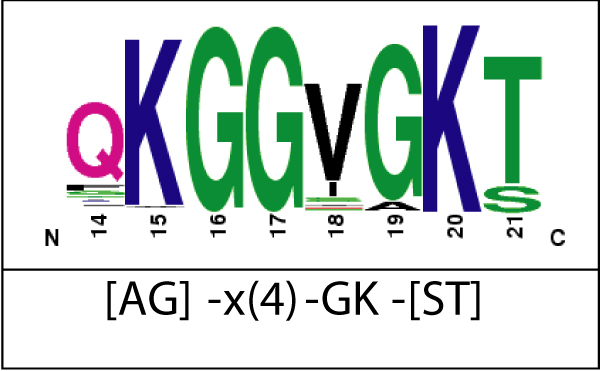
ATP binding motifs. The ATP-binding descriptor derived from PDB entry 2BEK and HSSP is compared to the the P-loop pattern (below). A single conflict occurs in the first position, and more specific detail is given about the second to the fifth residue. The descriptor therefore correctly detects other chromosome partitioning ATPases.